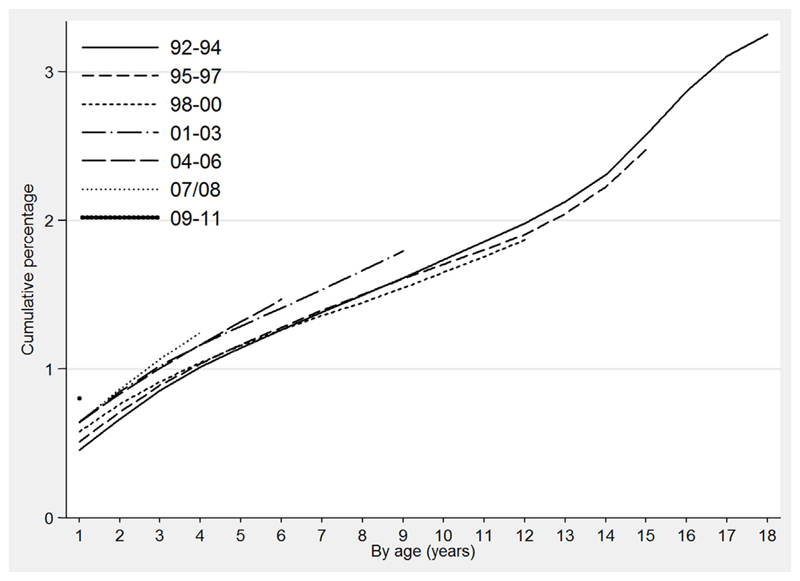
Cumulative proportion of children entering out-of-home care by grouped year of birth and age.